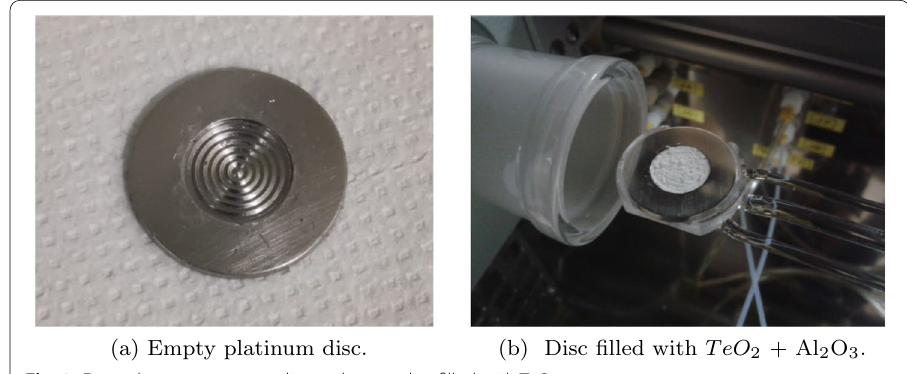
Fig. 2 Exemplary empty target disc and target disc filled with TeO